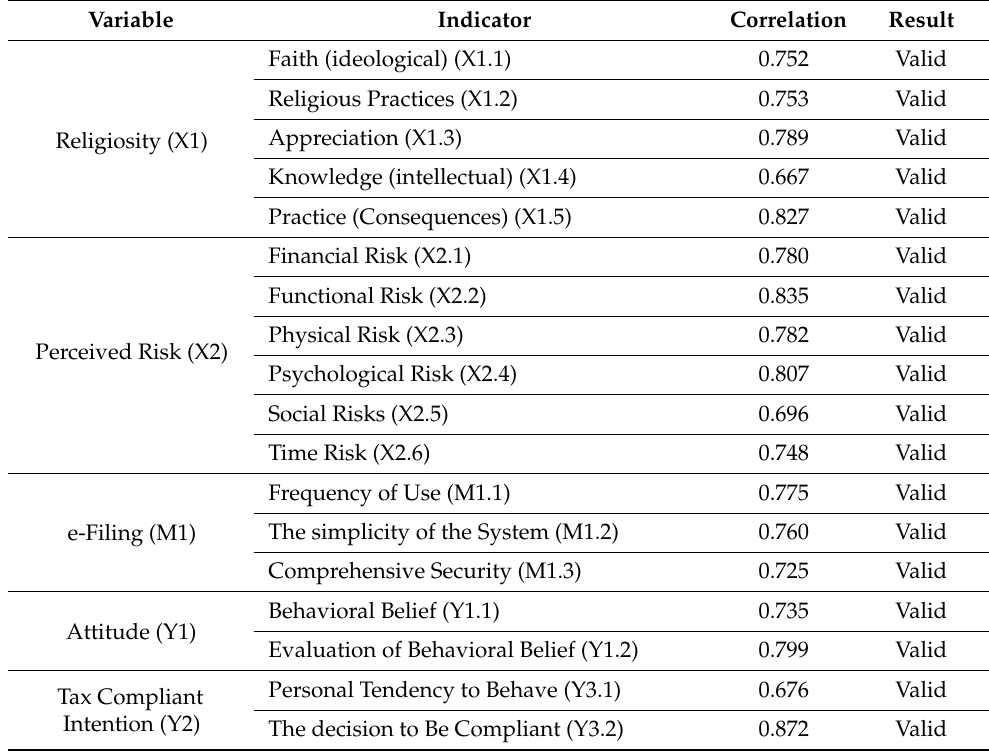
Table 1. Validity Test.